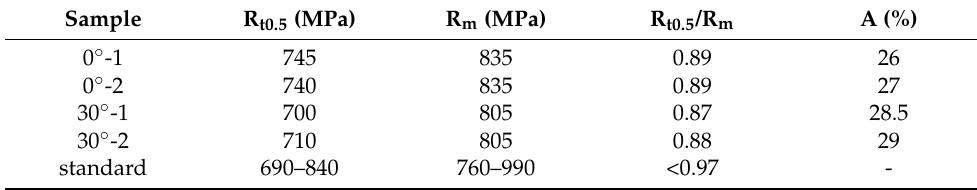
Table 2. Tensile properties of X100 pipeline steel strip.